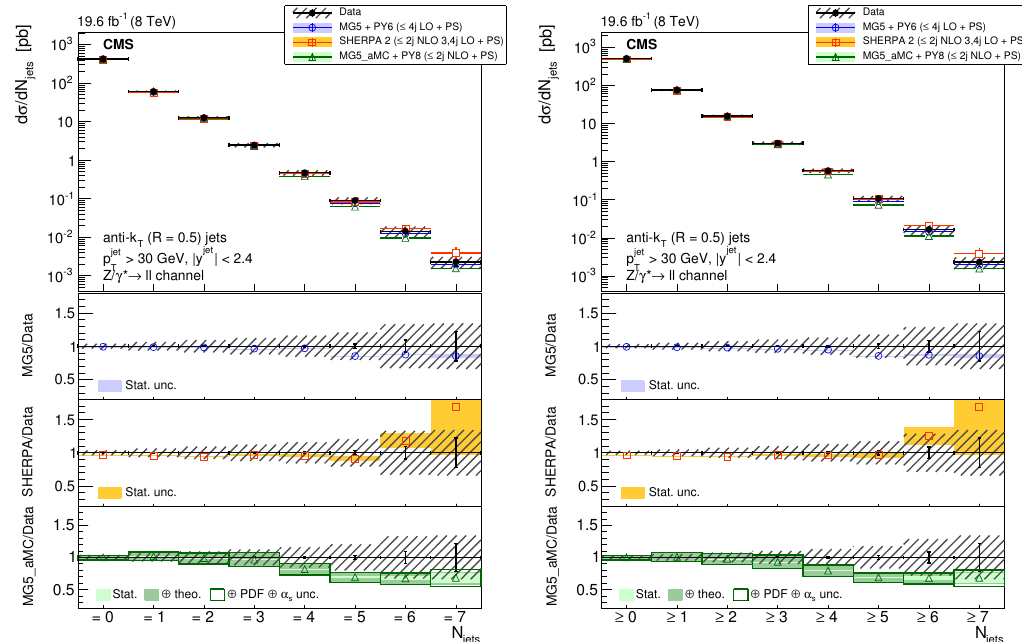
Figure 2 . The cross section for Z ( ! ‘‘ ) + jets production measured as a function of the (left) exclusive and (right) inclusive jet multiplicity distributions compared to the predictions calculated with MadGraph 5 + pythia 6, sherpa 2, and mg5 a mc + pythia 8. The lower panels show the ratios of the theoretical predictions to the measurements. Error bars around the experimental points show the statistical uncertainty, while the cross-hatched bands indicate the statistical and systematic uncertainties added in quadrature. The boxes around the mg5 a mc + pythia 8 to measurement ratio represent the uncertainty on the prediction, including statistical, theoretical (from scale variations), and PDF uncertainties. The dark green area represents the statistical and theoretical uncertainties only, while the light green area represents the statistical uncertainty